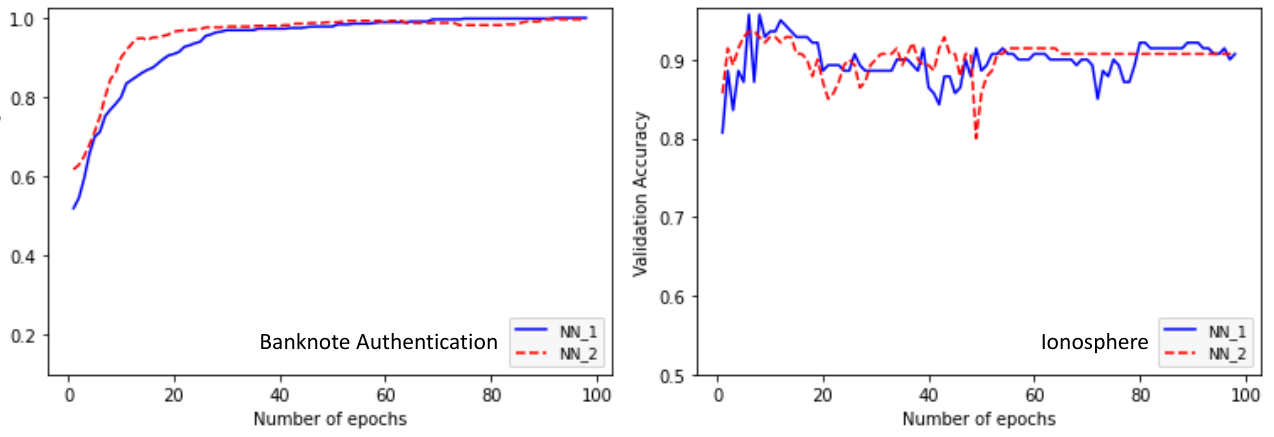
Figure 9. (Second Experiment) Classification (i.e., validation) accuracy evaluated on the testing data as a function of the number of training epochs obtained by the obtained by the best neural network (NN_1) using the Hyperspace A, and the best neural network (NN_2) using the Hyperspace B (Data sets: Bank Authentication, and Ionosphere). The corresponding hyperparameter values, accuracy, and total time (in minutes) needed for the hyper-tuning for each data set are given in Table 9. The last column in Tables 8 and 9 is the mean hyper-tuning time, which is the mean value of the AutoML pipeline’s execution time for performing the hyperparameter opti- mization in Hyperspace A and Hyperspace B.